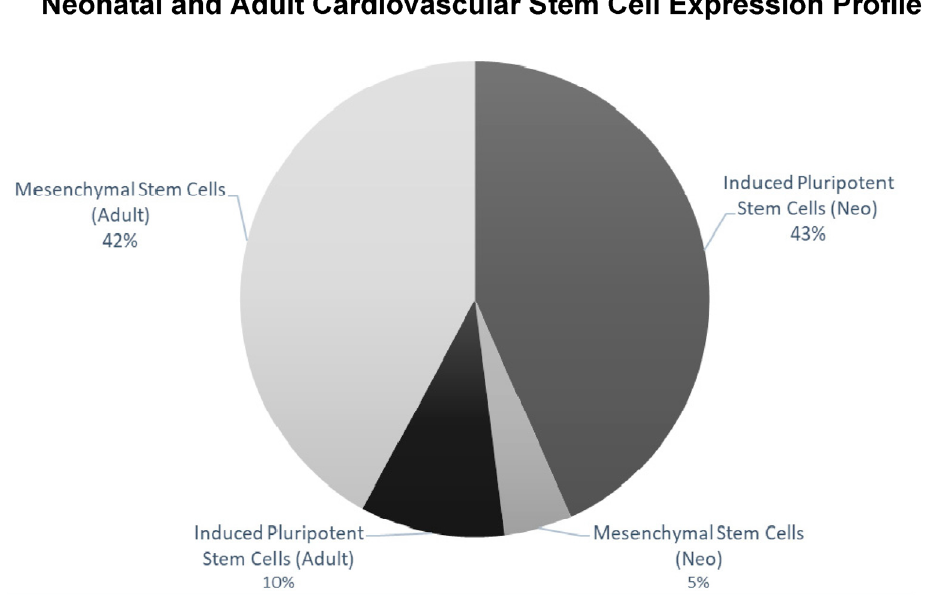
Figure 2. StemChecker demonstrates differences when comparing the iPSC and MSC expression profile for Isl-1+ neonatal and adult CPCs. Isl-1+ neonatal CPC (N = 3) transcriptome had the greatest number of transcripts corresponding to iPSCs. Isl-1+ adult CPC (N = 3) transcriptome had the greatest number of transcripts corresponding to MSCs.